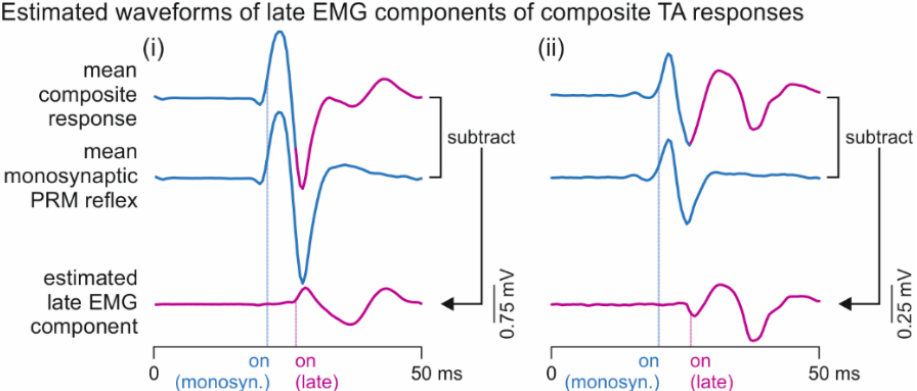
Figure A2. Estimated EMG waveforms of late components of composite TA responses. EMG waveforms were constructed by subtracting the averaged EMG waveform of all monosynaptic PRM reflexes from the composite responses evoked by EES with the same electrode setup and amplitude. Data derived from ( i ) subject 4, recording 5, electrode setup 0 ‐ c+, 6 V, and ( ii ) subject 7, recording 4, 0 ‐ 1+, 5 V. monosyn., monosynaptic; on, onset latency; PRM, posterior root ‐ muscle; TA, tibialis anterior.